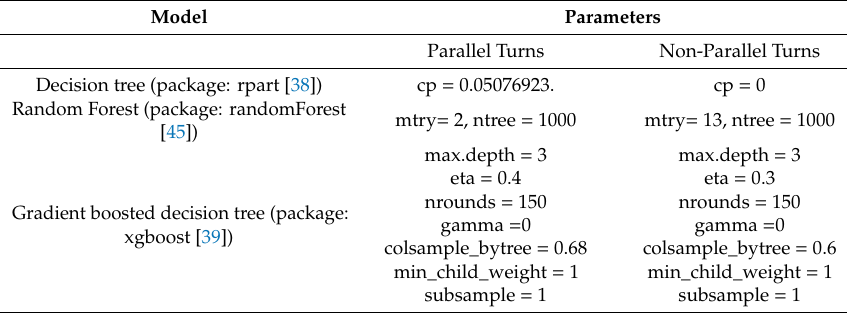
Table A4 lists the parameters used in the classification models. Table A4. List of parameters used in models.